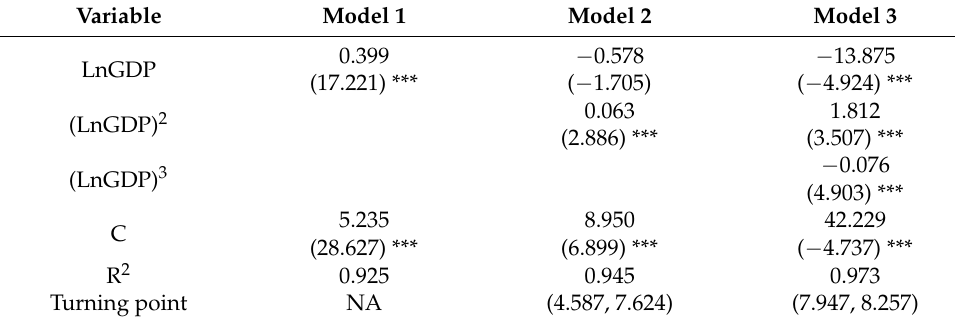
Table 10. Results of the test of the EKC for carbon